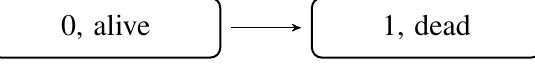
Figure 1. Survival Markov